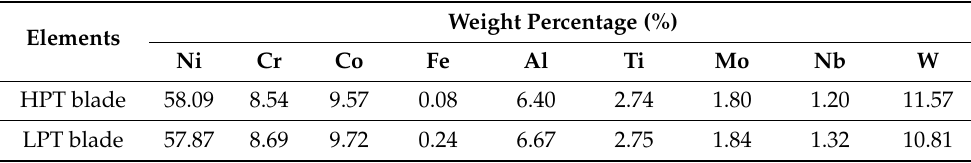
Table 3. Comparison with the microanalysis of the material of the HPT